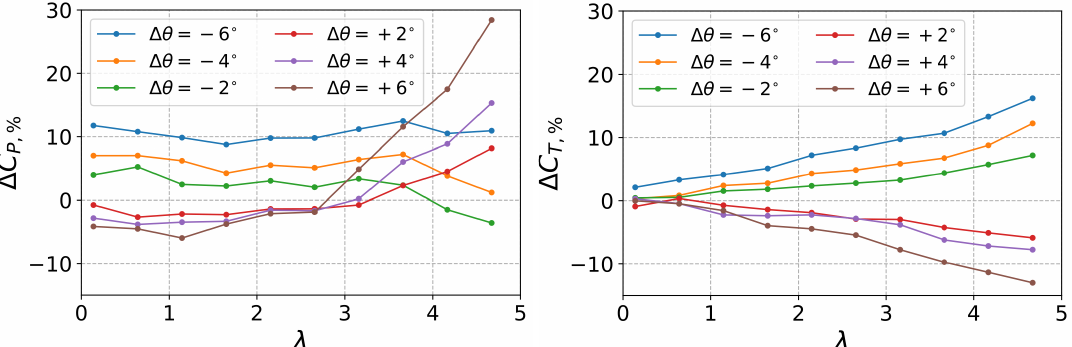
Figure 8. Effect of the pitch imbalance on the C P and C T coefficients, compared to the balanced